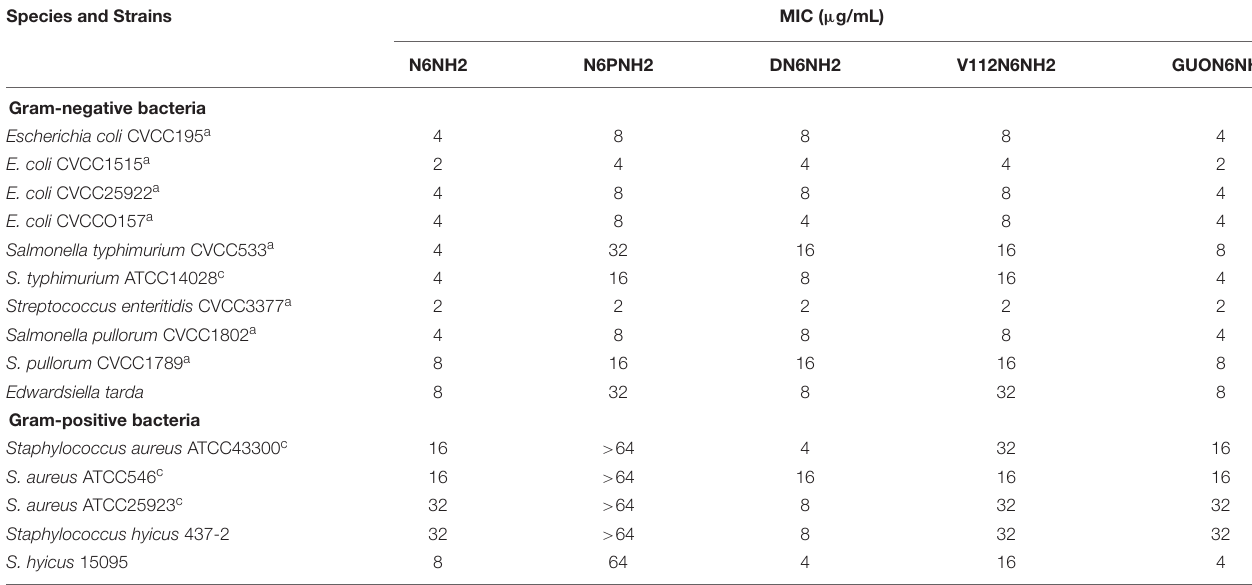
TABLE 2 | MIC values of N6NH2 and its analogs. Species and Strains